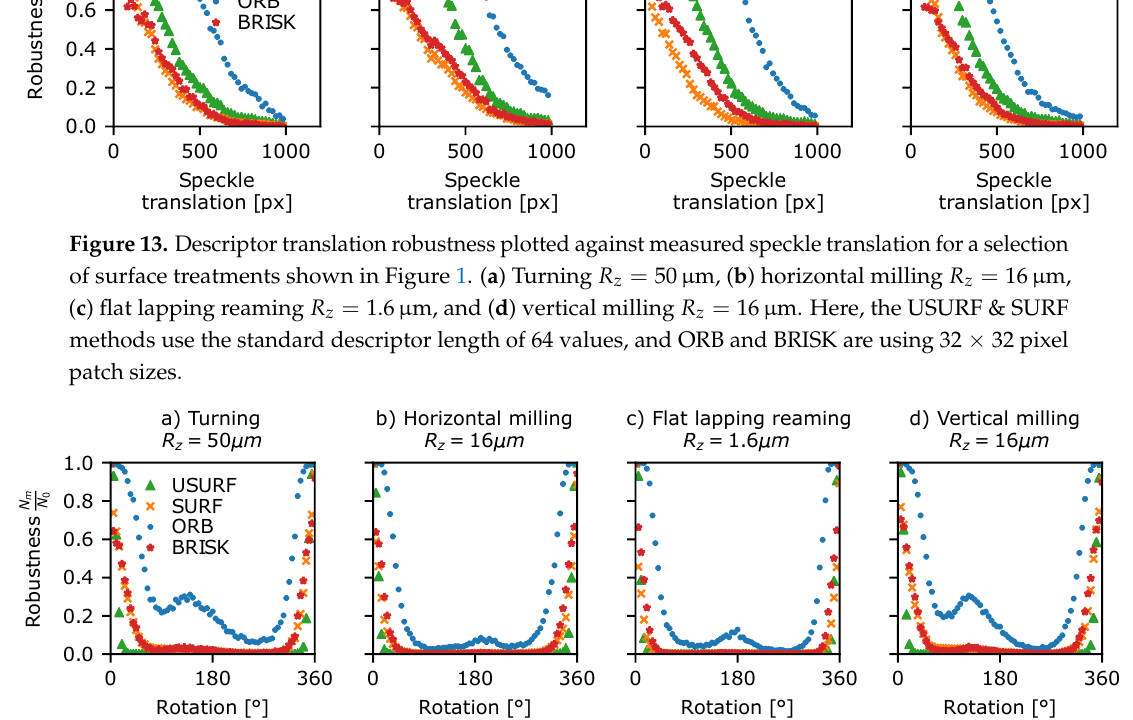
Figure 14. Descriptor rotational robustness plotted against applied rotation for a selection of surface treatments shown in Figure 1. ( a ) Turning R z = 50 µ m, ( b ) horizontal milling R z = 16 µ m, ( c ) flat lapping reaming R z = 1.6 µ m, and ( d ) vertical milling R z = 16 µ m. Here, the USURF & SURF methods use the standard descriptor length of 64 values, and ORB and BRISK are using 32 × 32 pixel patch